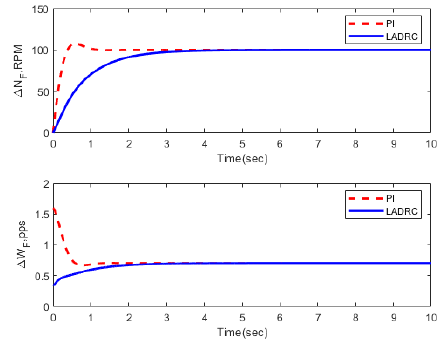
Figure 19. Step response of FC10.